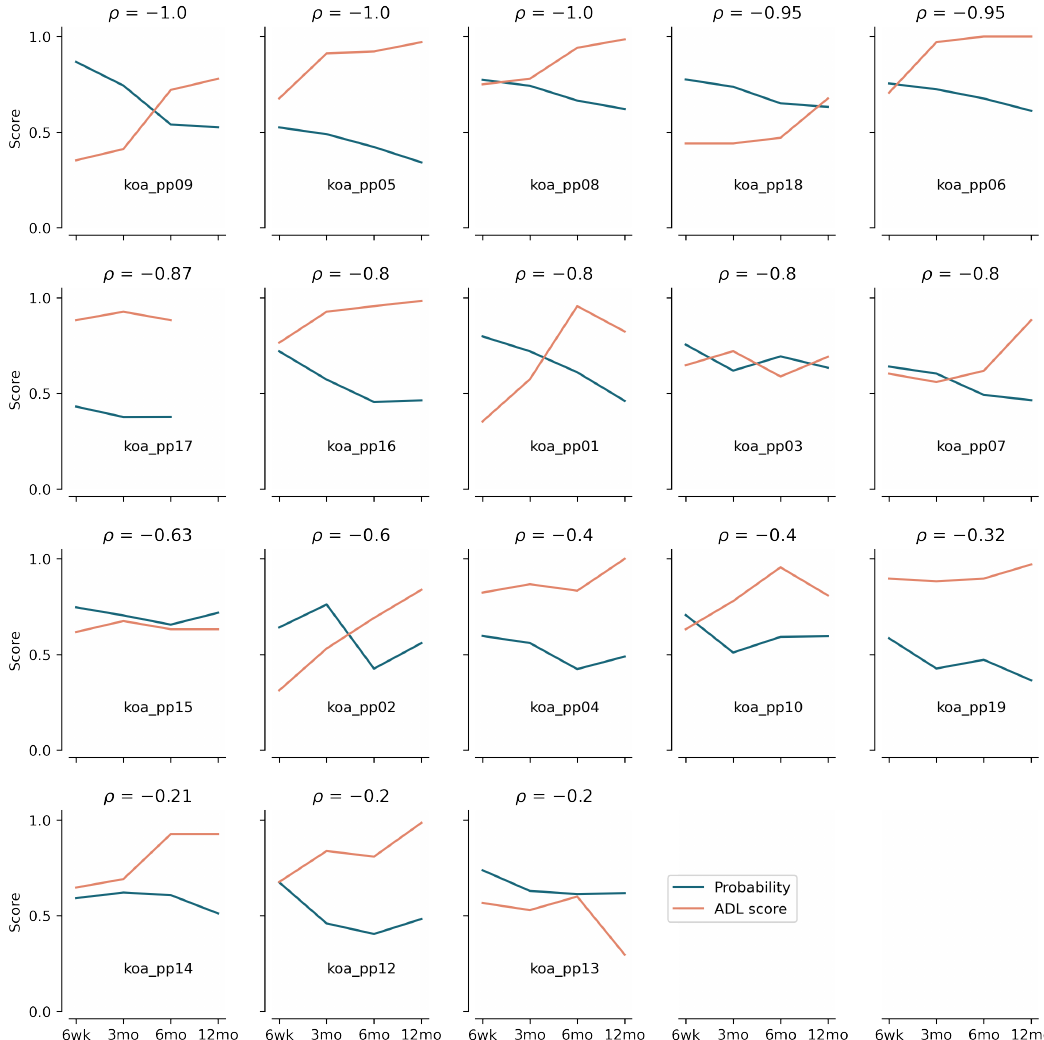
Figure 3. Evaluation time-curves of the probability of belonging to the TKA class (blue) and the patient-reported outcome (orange) per participant. The model used is trained on post-operative walking data and deployed on post-op walking. The headers of each subplot show the correlation coefficient. The subplots are sorted on highest correlation to lowest